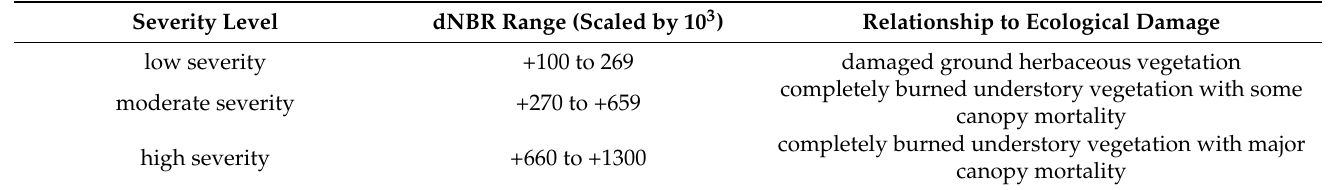
Table 1. Burn severity levels obtained calculating the differenced normalized burn ratio (dNBR), proposed by the United States Geological